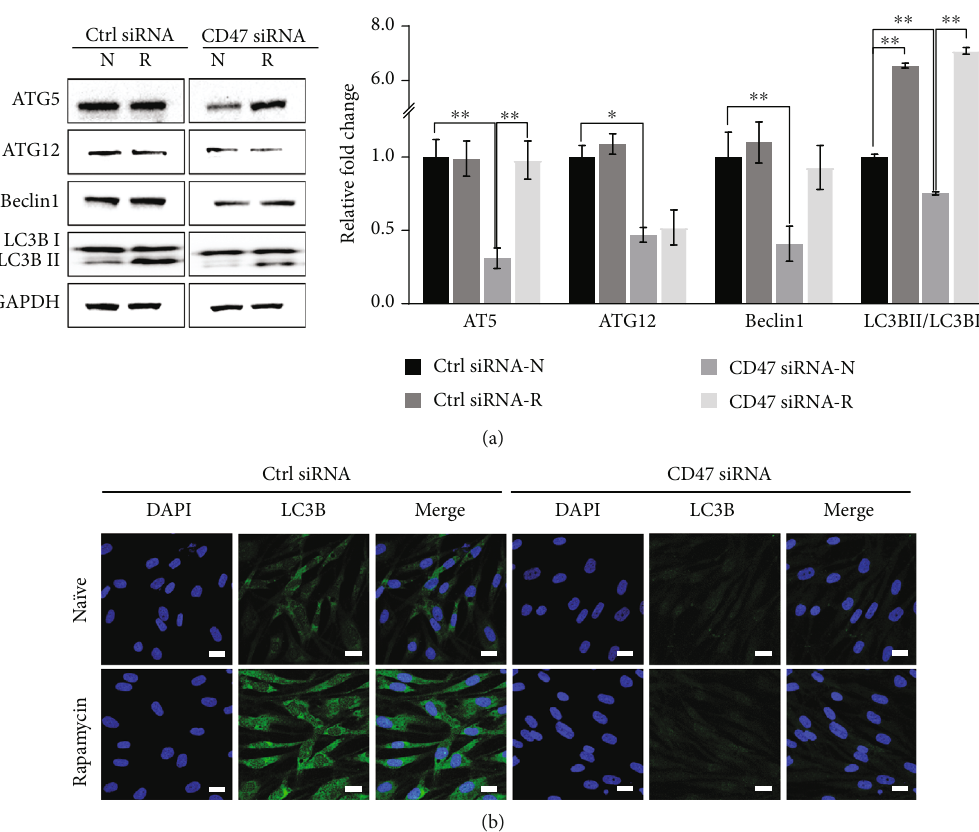
Figure 5: Autophagy fl ux. (a) Rapamycin (R, 10 μ M), autophagy inducer, was treated in CD47 knockdown UCB-MSCs. Autophagy-related proteins were determined with immunoblotting analysis. Relative fold change of proteins, ATG5, ATG12, Beclin1, and LC3BII relative to LC3BI was quanti fi ed against protein levels of GAPDH. (b) Representative immuno fl uorescence images of LC3 with treatment of autophagy inducer or inhibitors showed signi fi cant di ff erent intensities on LC3 levels, contingent upon CD47 levels. Scale bar 20 μ m. Data is expressed as the mean ± SD ; n = 3 ; ∗∗ p < 0 : 01 , ∗ p < 0 : 05